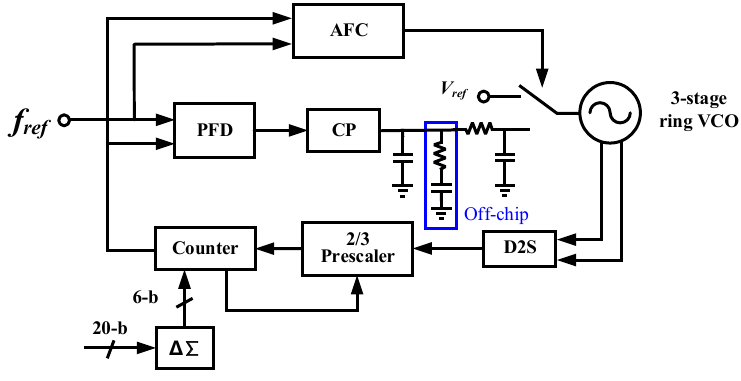
Figure 5. Phase-locked loop (PLL) block